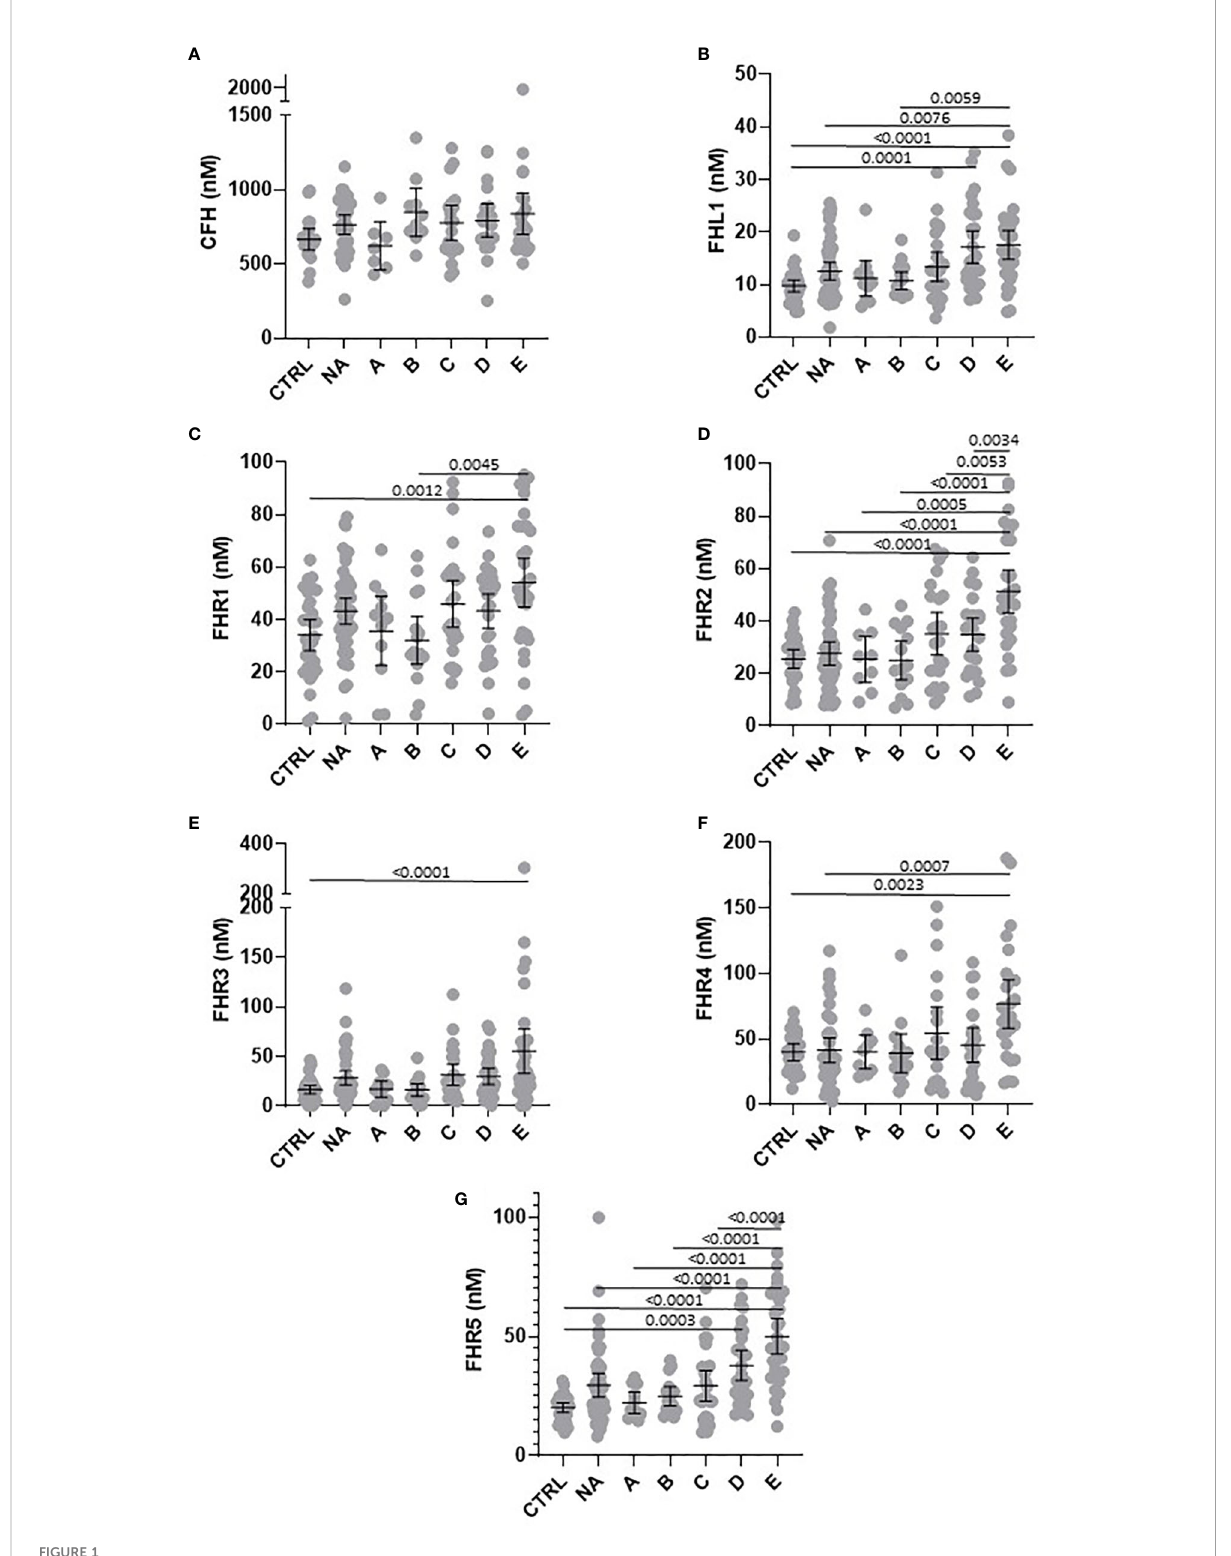
FIGURE 1 Circulatingconcentration of FHL-1andFHR1toFHR5iselevatedinCOVID-19 patients. ScatterplotsofFH (A) , FHL1 (B) , andFHR1toFHR5 (C – G) representthemeasuredplasmaprotein concentrationinnM. Pairwiseadjustedp-valueswereobtainedfromaTukey ’ smultiplecomparisonstest